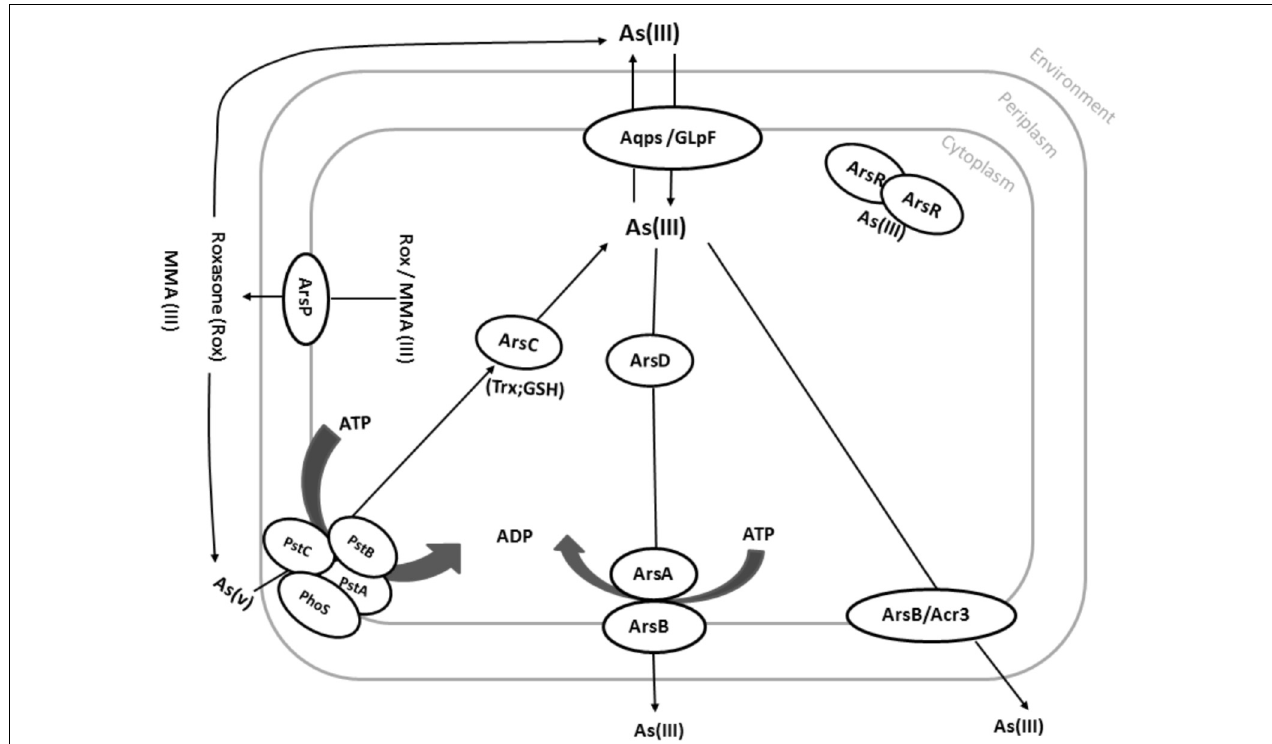
FIGURE 3 | Common pathways in arsenic resistance on prokaryotes. Under aerobic conditions, As(V) enters the cell via phosphate uptake systems (here PstA, PstB, PstC, and PhoS). As(V) is then reduced by the arsenate reductase ArsC to As(III). Although As(III) is more toxic than As(V), As(III) can easily be distinguished from phosphate, which is very similar to As(V). As(III) can also directly be taken up by various aquaglyceroporins such as GlpF from E. coli . As(III) can then be translocated across the cytoplasmic membrane via Acr3 or ArsB using the proton motive force (PMF). Alternatively, As(III) can be bound by the As(III)-binding chaperone ArsD and delivered to the ATP-dependent ArsAB efflux pump. Organic arsenic compounds such as MMA(III) and Roxarsone can also be pumped out by the ArsP transporter.